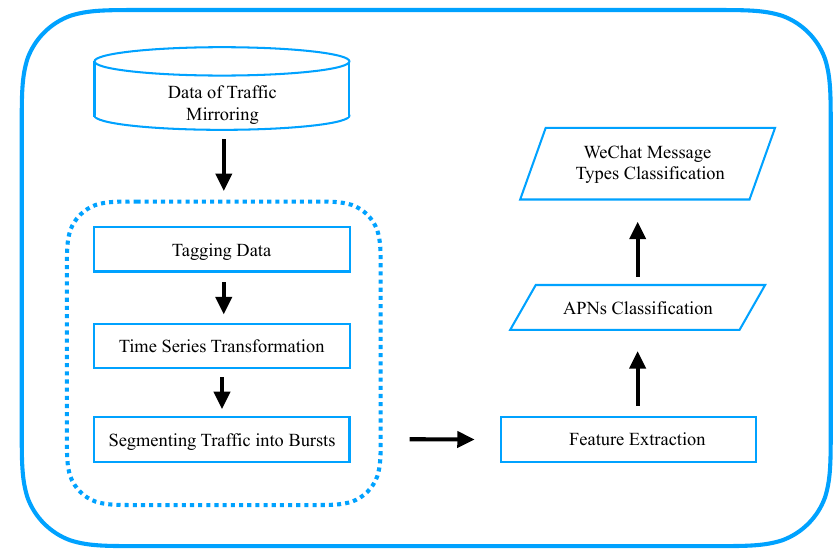
Figure 2. Framework of proposed method.